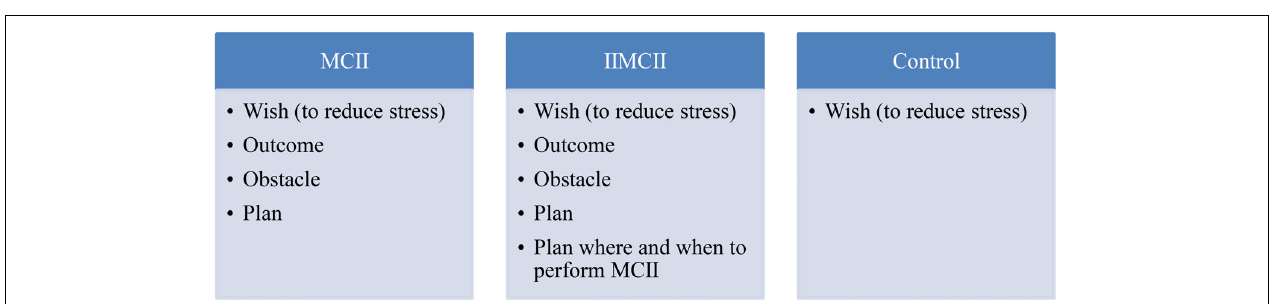
FIGURE 2 | Schematic overview of the intervention instructions provided in the three conditions: MCII, IIMCII, and control.